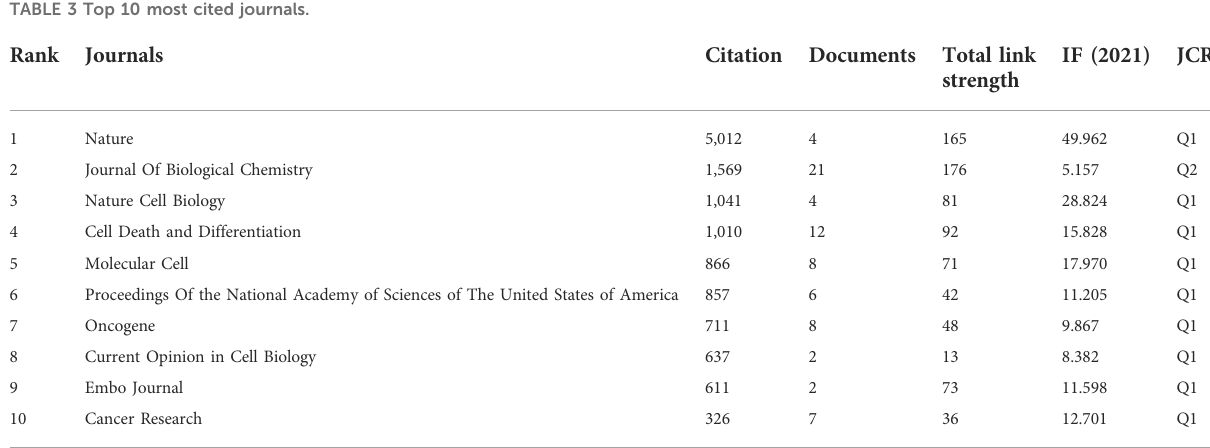
TABLE 3 Top 10 most cited